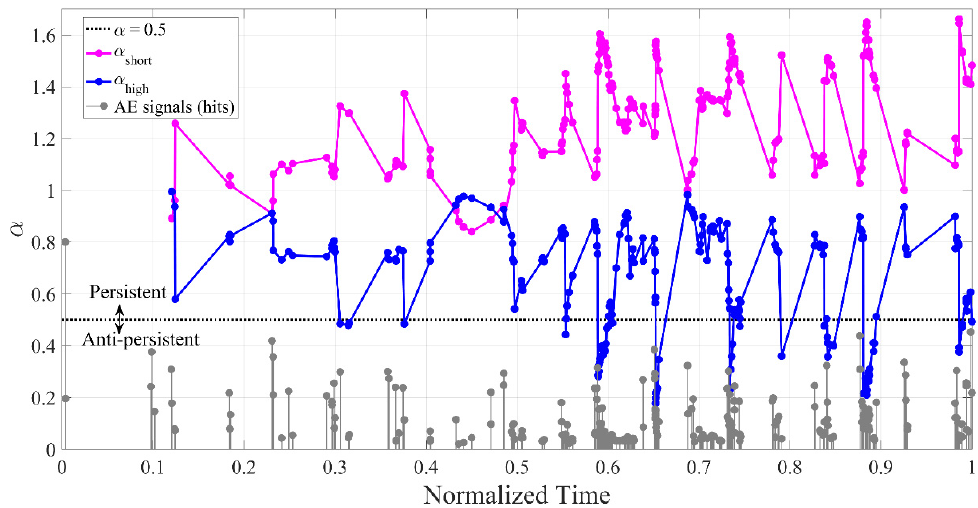
α ) time ranges for the spaghetti α ) and large ( high short